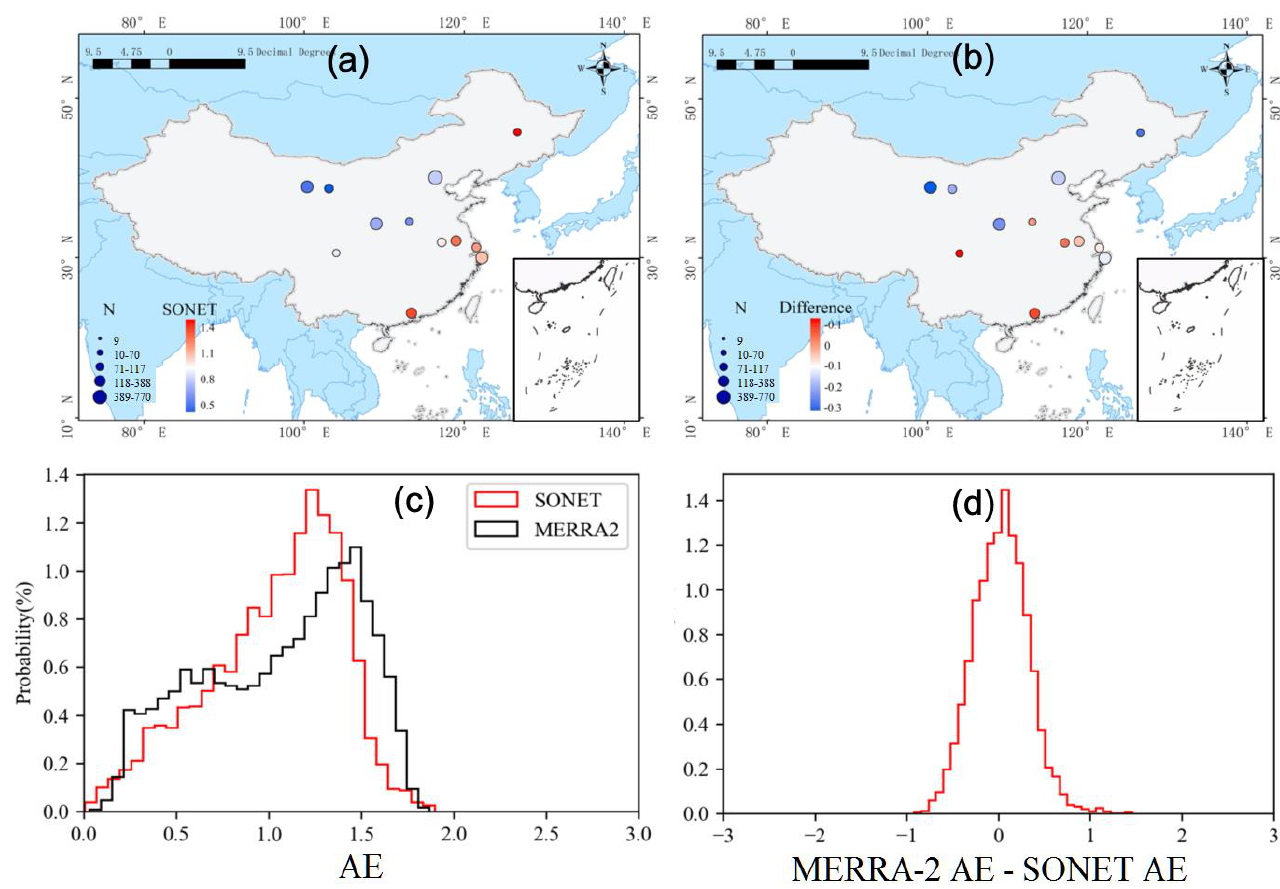
Figure 5. Same as Figure 3, but for AE.